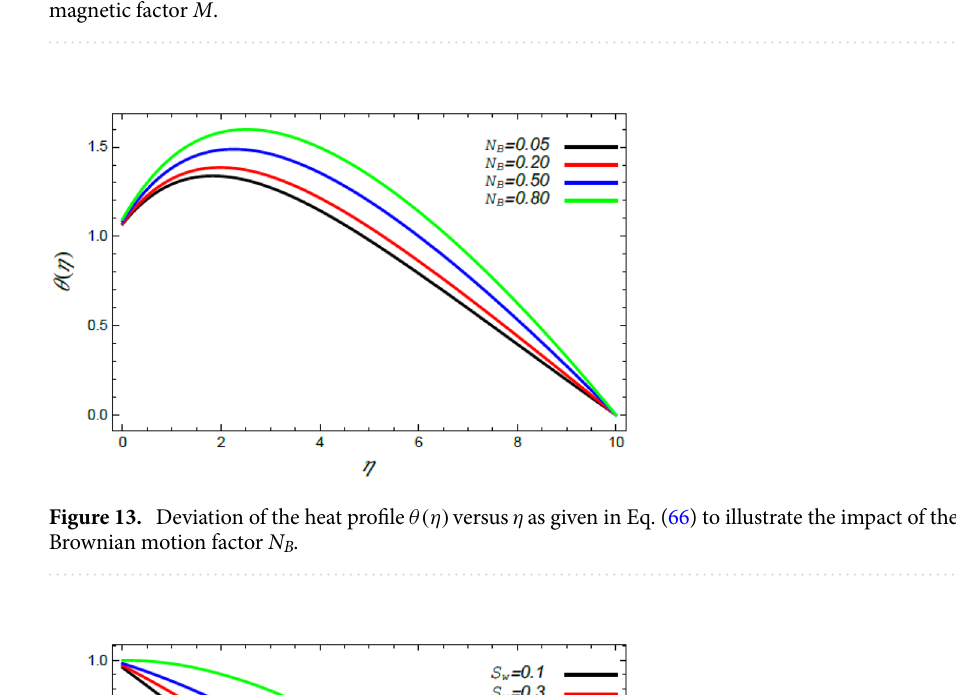
Figure 12. Deviation of the temperature profile θ(η) versus η as given in Eq. (66) to illustrate the impact of the magnetic factor M .